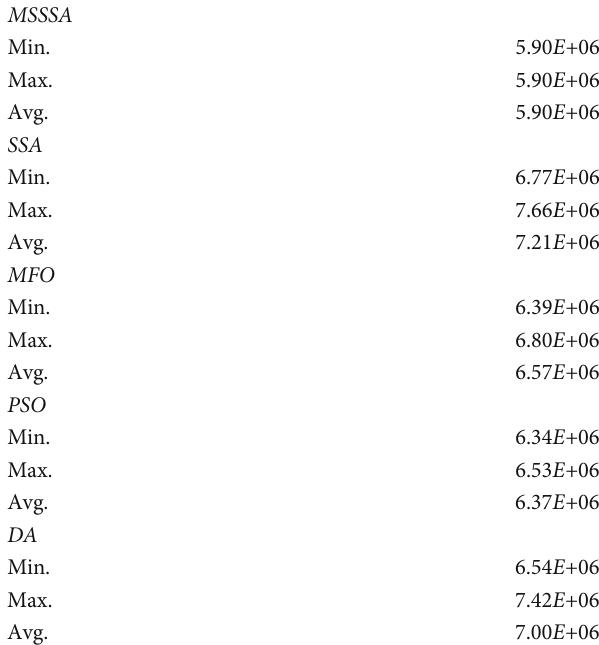
Table 4: HESS EV energy